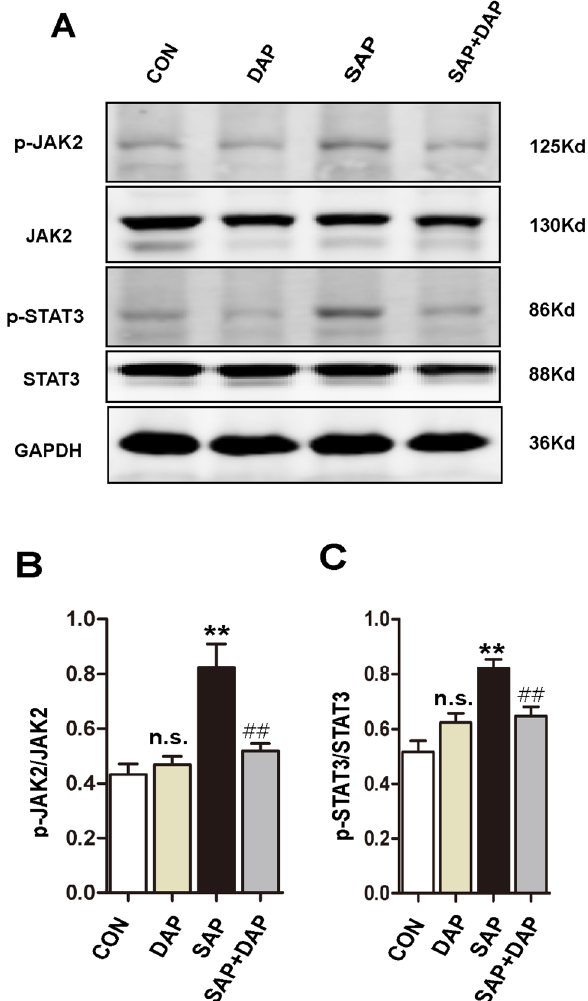
Figure 5. Daphnetin inhibits activation of the JAK2–STAT3 pathway in the lungs of mice with PALI. ( A ) Western blot analysis of p-JAK2, JAK, p-STAT3 and STAT3 expression in lung of each group, Bar graph showed the ratio of p-JAK2: total JAK2 protein ( B ). p-STAT3: total STAT3 protein ( C ). Full-length blots are presented in Supplementary Figure 2. The data are presented as the means ± SD. The histograms were created using GraphPad 5 software(GraphPad Prism 5.01 http:// www. xdowns. com/ soft/ xdown s2009. asp? softid= 49668 & downid= 60& id= 52443). The quantitative analysis of blots was used by ImageJ software(Image J 2 system software https:// imagej. net/ Downl oads). Full-length blots are presented in Supplementary Figure 2. CON group, l-arginine vehicle + daphnetin vehicle; SAP group, l-arginine + daphnetin vehicle; DAP group, l-arginine vehicle + daphnetin; SAP + DAP group, l-arginine + daphnetin. n = 3 /group, data are representative of three independent experiments. ** P < 0.01 versus CON group; ## P < 0.01 versus SAP group, n.s. P > 0.05 versus CON